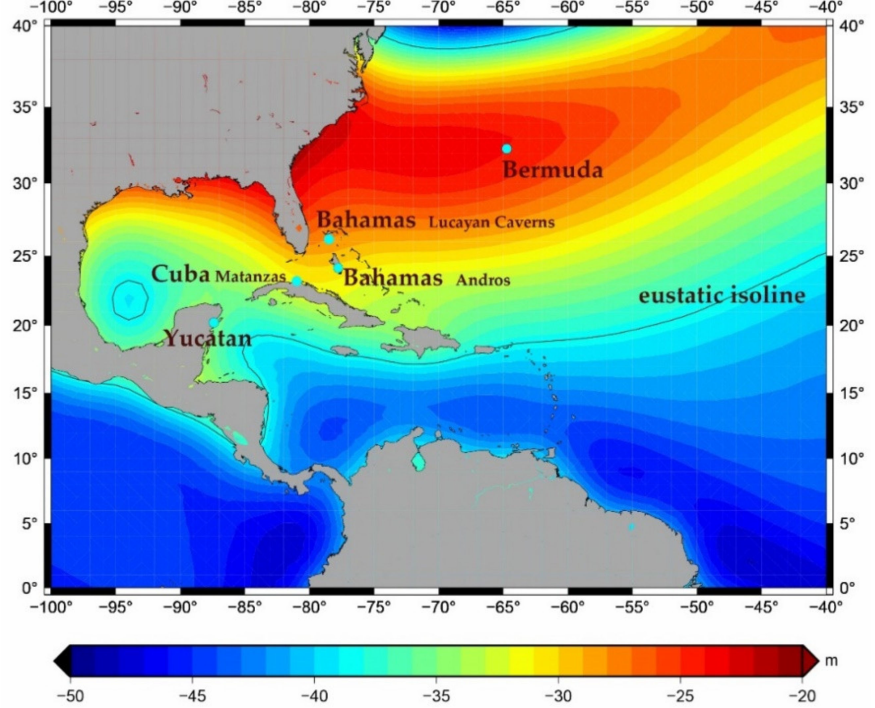
Figure 15. Predicted RSL elevation in the Caribbean Sea during MIS 5.1 according to ANICE-SELEN and the MVP 3 mantle viscosity profile. The light blue dots indicate the location of the sites. The black isoline shows the eustatic value ( − 38.5